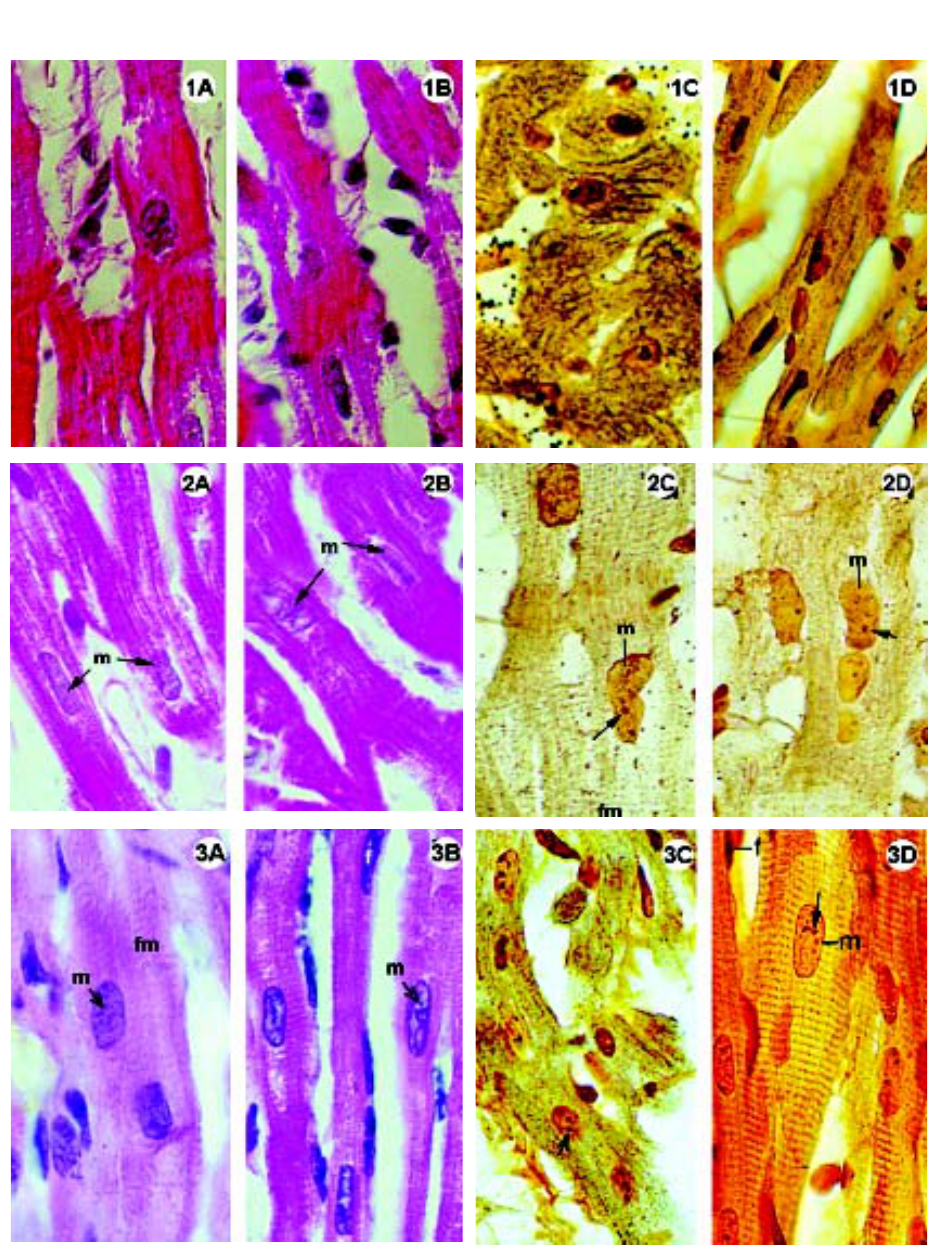
Fig. 1-3 - Histological sections of the lateral wall of the left ventricle of rabbit hearts, submitted to the Langendorff system, stained using hematoxylin-eosin (1A-B; 2A-B; 3A-B); impregnated with silver ions (1C-D; 2C-D; 3C-D). Magnification: 1080 x 1A-D: Experimental Group I, heart submitted to cardiac arrest protected with a low-volume cardioplegic solution (LVCS). Staining by hematoxylin- eosin demonstrates basophils and myocardial fibers with acidophil sarcoplasm retracted around the nucleus and with a fragmented aspect (1A- B). Impregnation by silver ions evidenced the nucleolar corpusculas positively marked (1C-D). Magnification: 1080 x 2A-D: Experimental group II, hearts submitted to cardiac arrest protected with LVCS, followed by perfusion with oxygenated Ringer Locke solution. Staining by hematoxylin-eosin shows preserved elongated nuclei and nuclei and myocardial fibers with a fragmented appearance (2A- B). Staining with silver ions evidenced nucleolar corpusculas and fibers with transversal striations positively marked. Magnification: 1080 x 3A-D: Control group, hearts perfused with an oxygenated Ringer Locke solution. A-B: Staining by hematoxylin-eosin, shows myocardial fibers with acidophil sarcoplasm and standard striation, elongated and central basophil nuclei. C-D: Impregnation by silver ions evidenced transversal striations of fibers inside the various nuclei of the nucleolar corpusculas positively marked (D). Magnification: 1080 x m = nucleus of muscle cell; f = fibroblast nucleus; fm = muscle fiber; small arrow = nucleolar corpuscula. Magnification: 1080